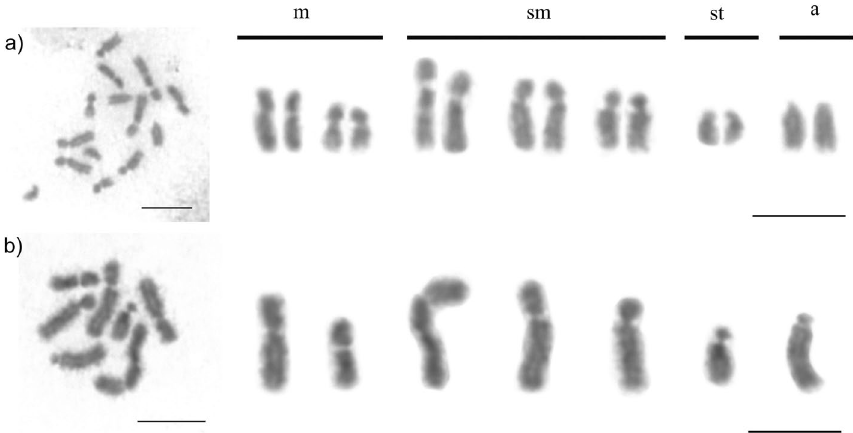
Figure 7. Metaphase chromosomes stained with Giemsa and the respective karyotypes from a sexual population of the fungus-growing ant Mycocepurus smithii . ( a ) Female (2n = 14) and ( b ) male (n = 7). m metacentric, sm submetacentric, st subtelocentric, a acrocentric. Scale bar represents 5